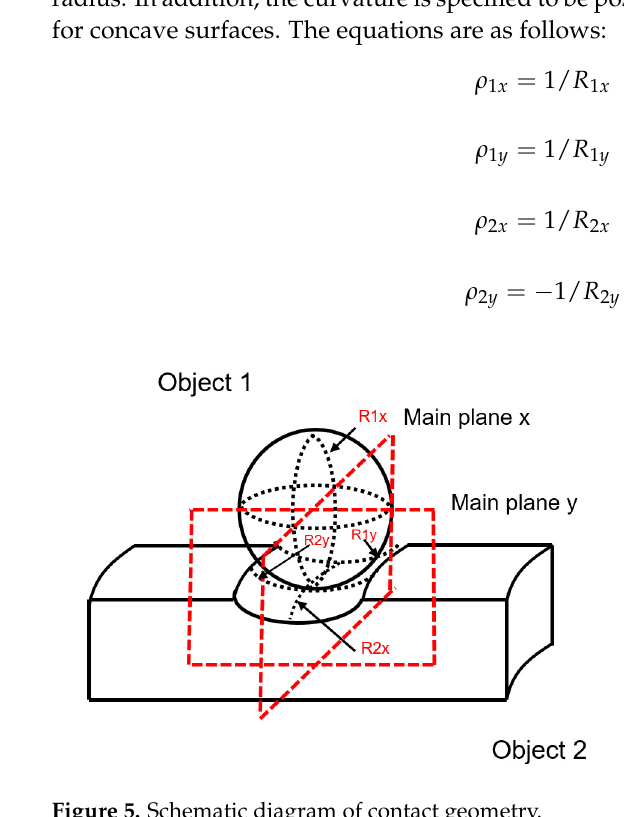
Figure 5. Schematic diagram of contact geometry.